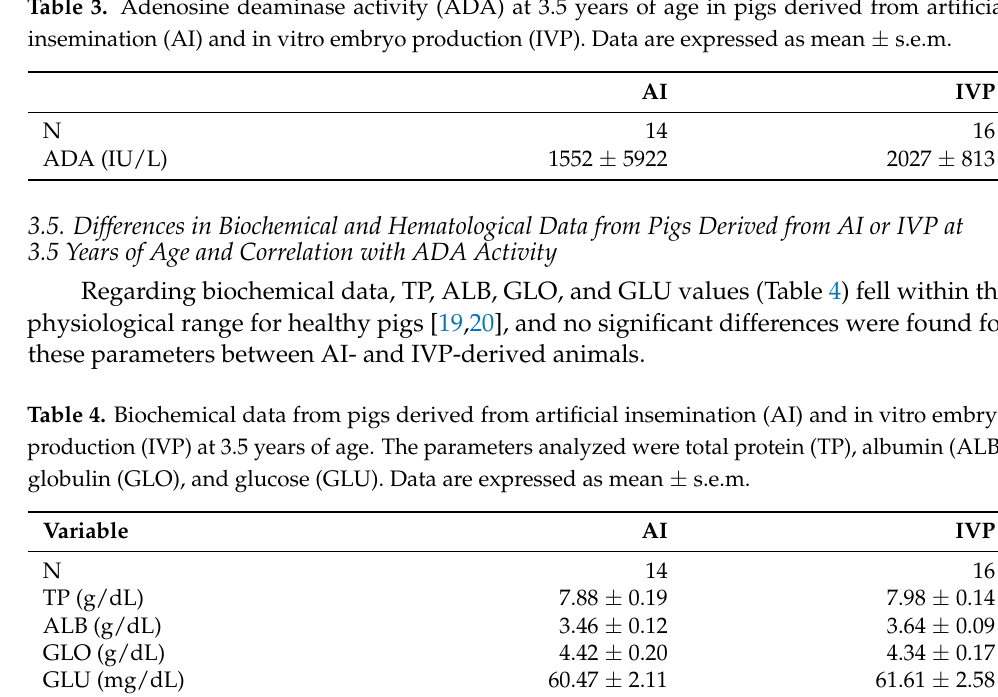
Table 3. Adenosine deaminase activity (ADA) at 3.5 years of age in pigs derived from artificial insemination (AI) and in vitro embryo production (IVP). Data are expressed as mean ± s.e.m.